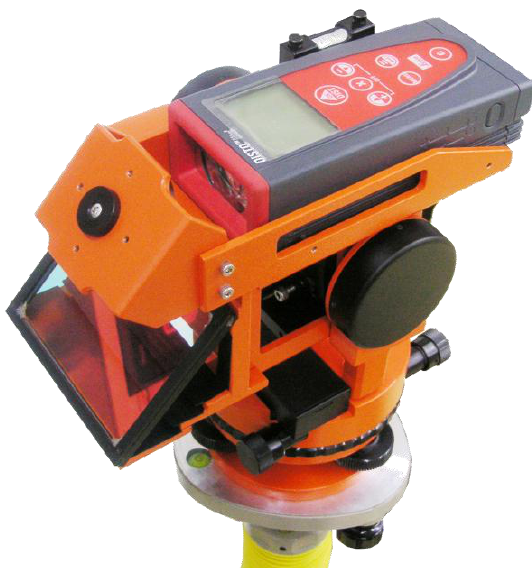
Figure 1. IBIM system device.